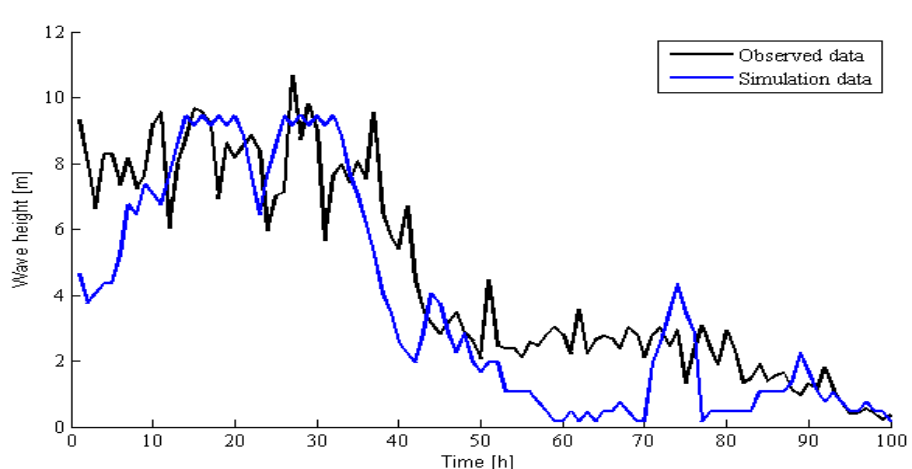
Figure 10. The comparison of predicted and observed values of wave height, wave height prediction curve with ∆ H s = 0.3 m.